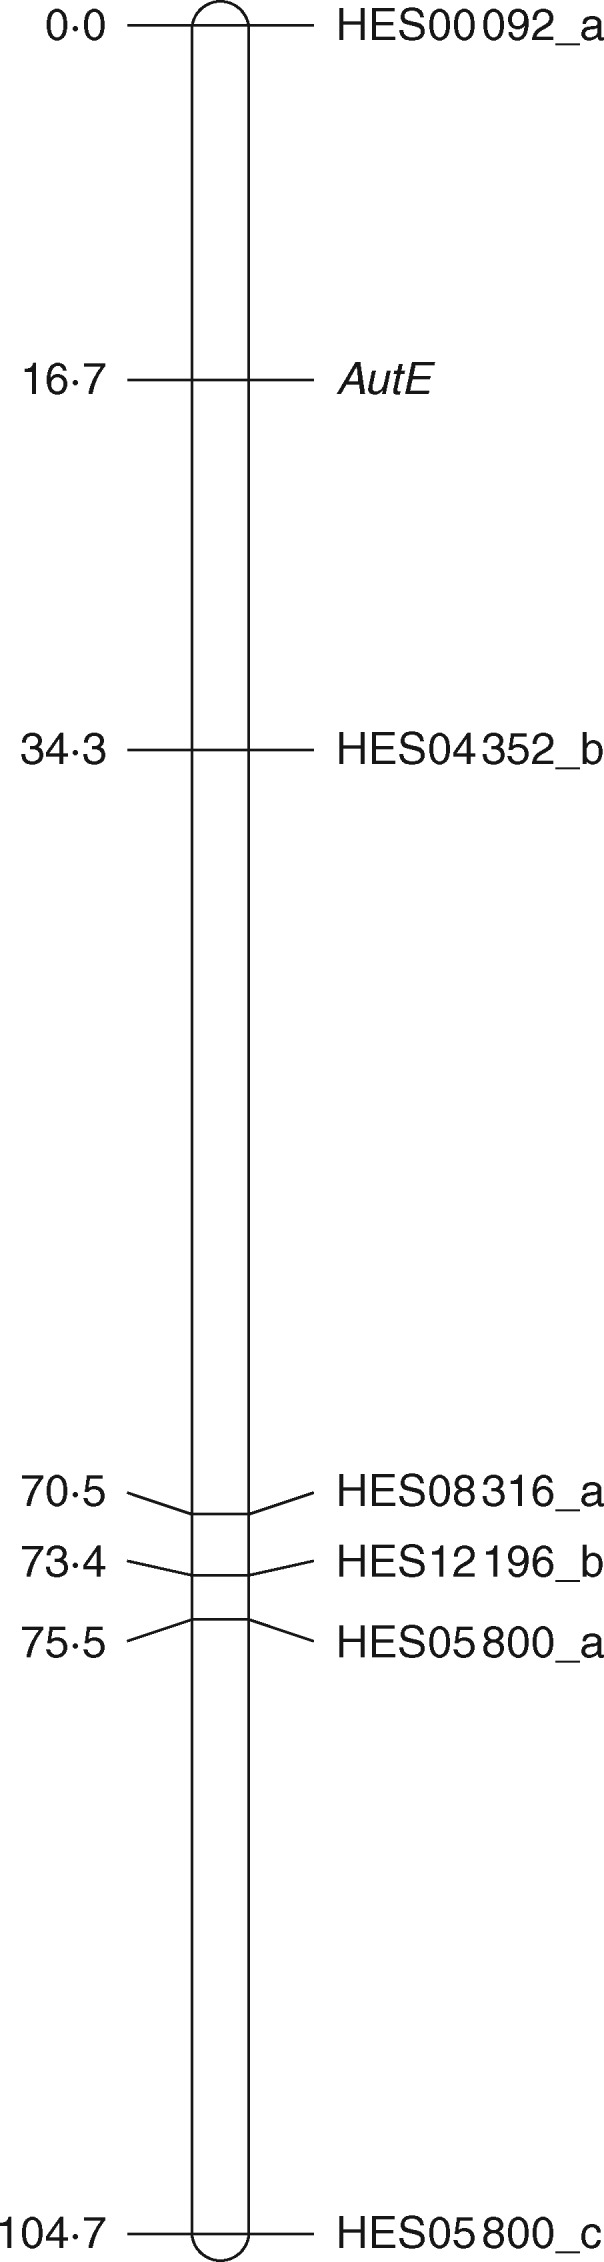
Genetic linkage group in AutE196 encompassing the autonomous endosperm (AutE) locus. Six ovule expressed EST-SSR markers grouped together with the autonomous endosperm phenotype. Markers and map distances (cM) are shown to the right and left of the horizontal lines, respectively.